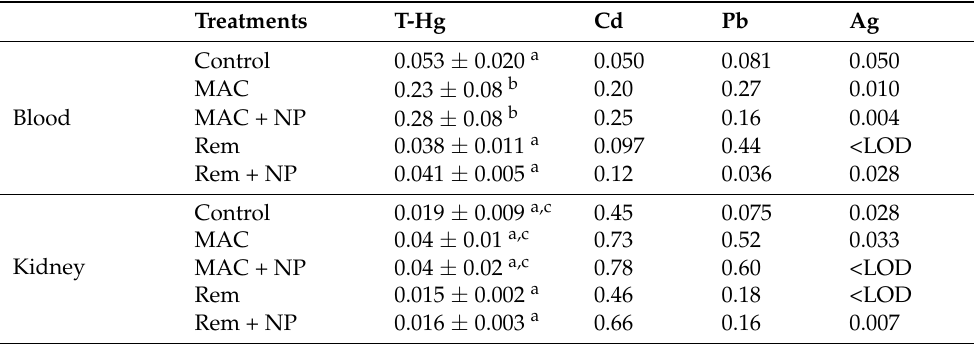
Table 1. Mean concentrations ( µ g/g, fresh weight) of total mercury (T-Hg), cadmium (Cd), lead (Pb), and silver (Ag) in the blood and kidneys of turbot ( S. maximus ) exposed to different metallic mixtures, with and without nanoparticles, for 7 consecutive days. T-Hg data are represented by mean ± standard deviation and different lower-case letters denote significant differences ( p <